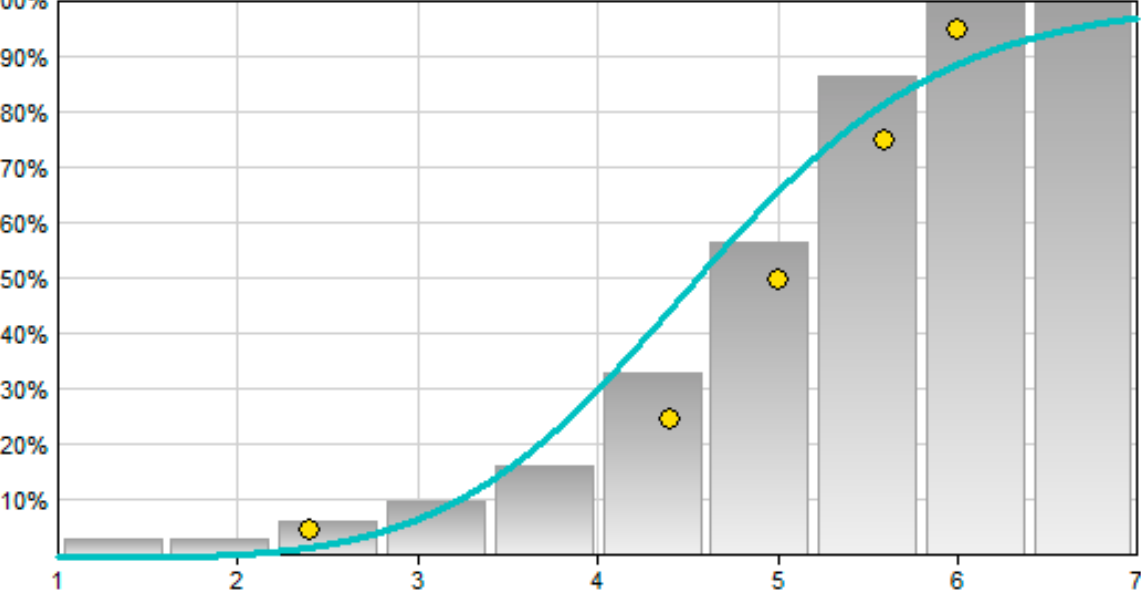
Figure 6. Empirical Distribution Function (sea color line) for daily energy produced by the WSEI carport in the month of June 2022 and quantile parameters (yellow symbols).